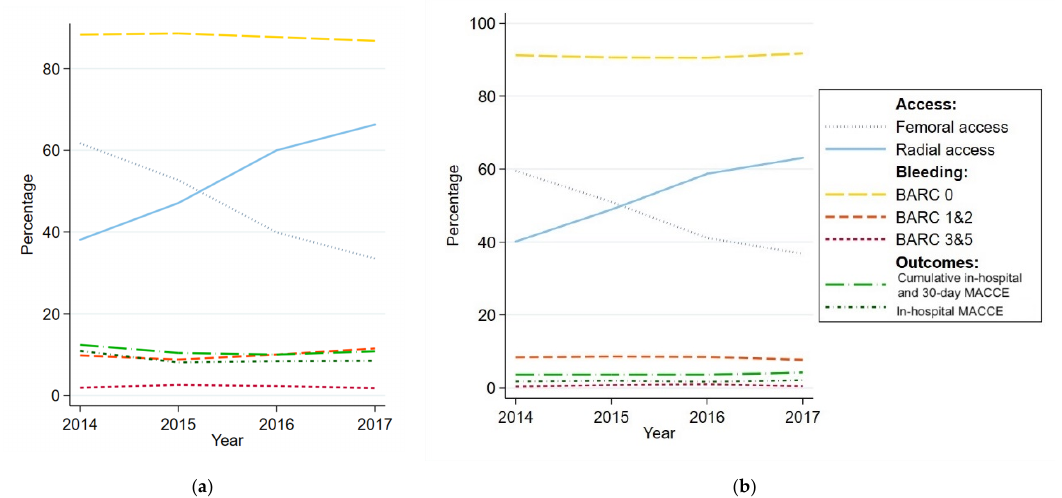
Figure 3. Trends in mode of vascular access, bleeding, and MACCE between 2014 and 2017 among STEMI patients, and ACS patients excluding STEMI. ( a ) STEMI Figure3. Trendsinmodeofvascularaccess, bleeding, andMACCEbetween2014and2017amongSTEMI patients, ( b ) ACS patients (excluding STEMI). patients, and ACS patients excluding STEMI. ( a ) STEMI patients, ( b ) ACS patients (excluding